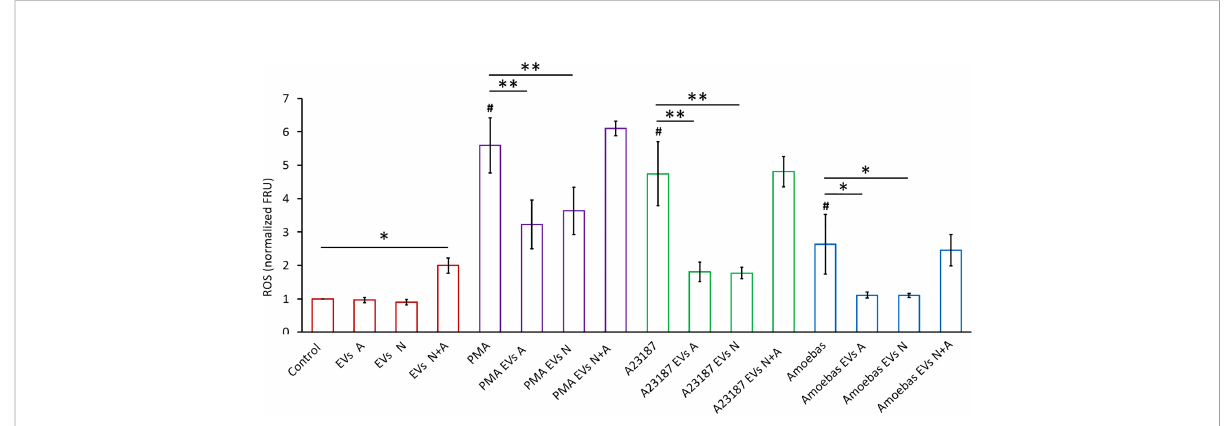
FIGURE 4 ROS detection in neutrophils stimulated with EVs. H 2 DCFDA stained neutrophils (1 × 10 5 ) were transferred to 96 well plates and allowed to sediment. EVs (10 µg) from trophozoites (Exo A), neutrophils (Exo N), or coculture (Exo N+A) were added to neutrophils and then immediately stimulated or not with PMA (50 nM), A23187 (10 µM) or 10 3 E. histolytica trophozoites. Fluorescence was measured after 1 h, data were normalized with respect to control and fl uorescence relative units (FRU) were graphed. Graphs represent mean ± SD of three independent experiments. * p < 0.05; ** p < 0.01; # signi fi cant difference respect to